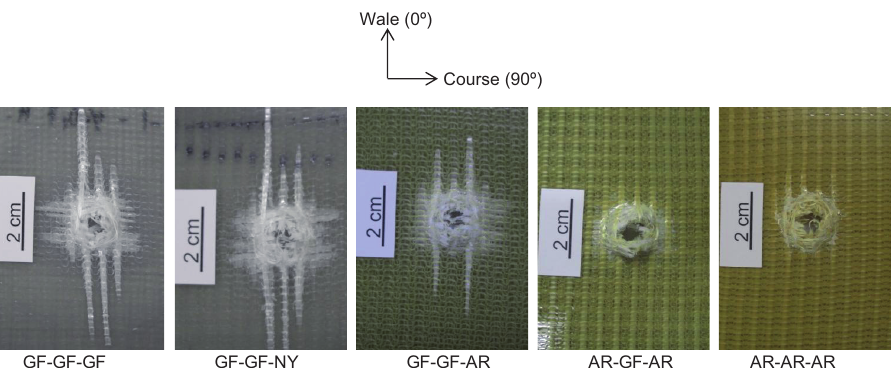
Figure 7 The fracture aspects of the reverse side of the plate bending impact-tested specimens.